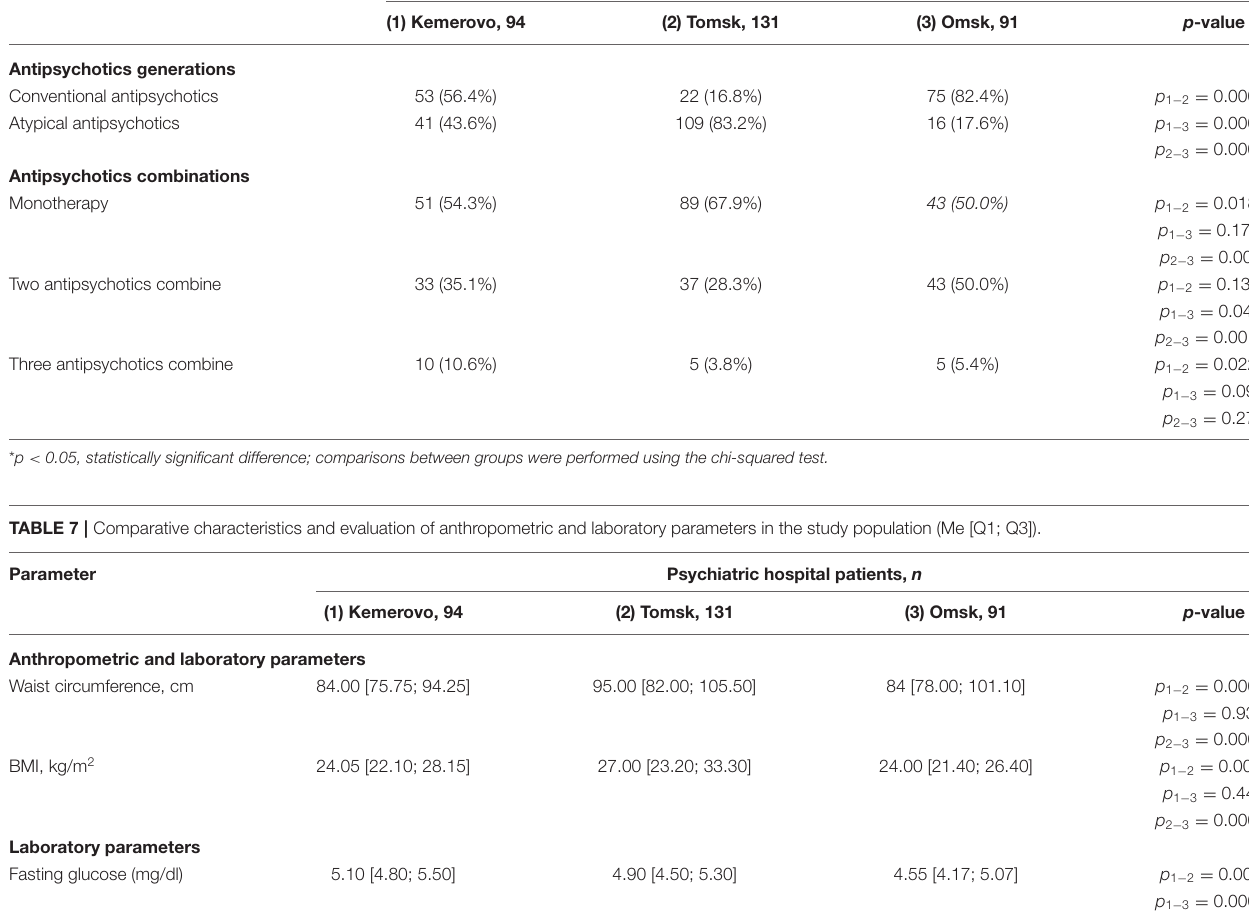
TABLE 6 | Comparative characteristics and evaluation of antipsychotics generations and antipsychotics combinations, n (%). Antipsychotics combinations